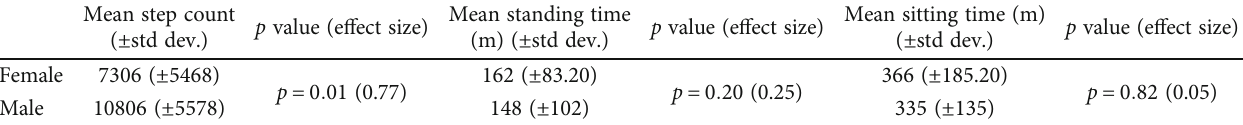
Table 4: Comparison between male and female daily steps, standing time (minutes), and sitting time (minutes) ( mean ± std dev : ). Mean step count ( ± std dev.)